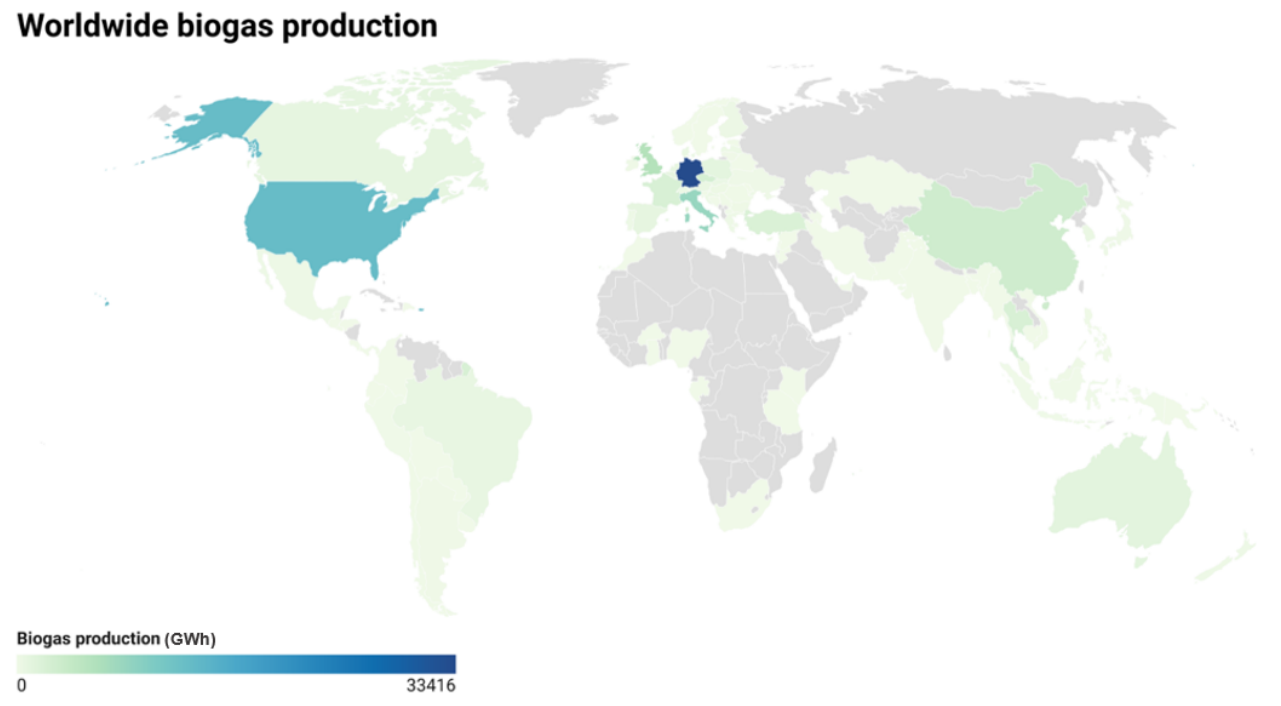
Figure 2. Total biogas production for power generation for each country at the end of 2018 .